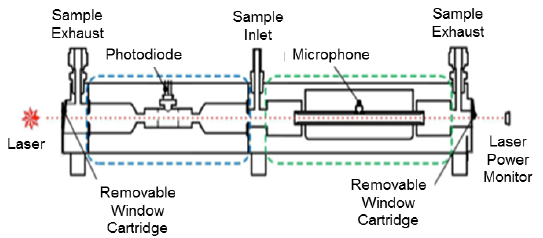
Figure 2. Diagram showing the scattering (blue dashed region) and absorption (green dashed region) cells in the Photoacoustic Extinc- tiometer